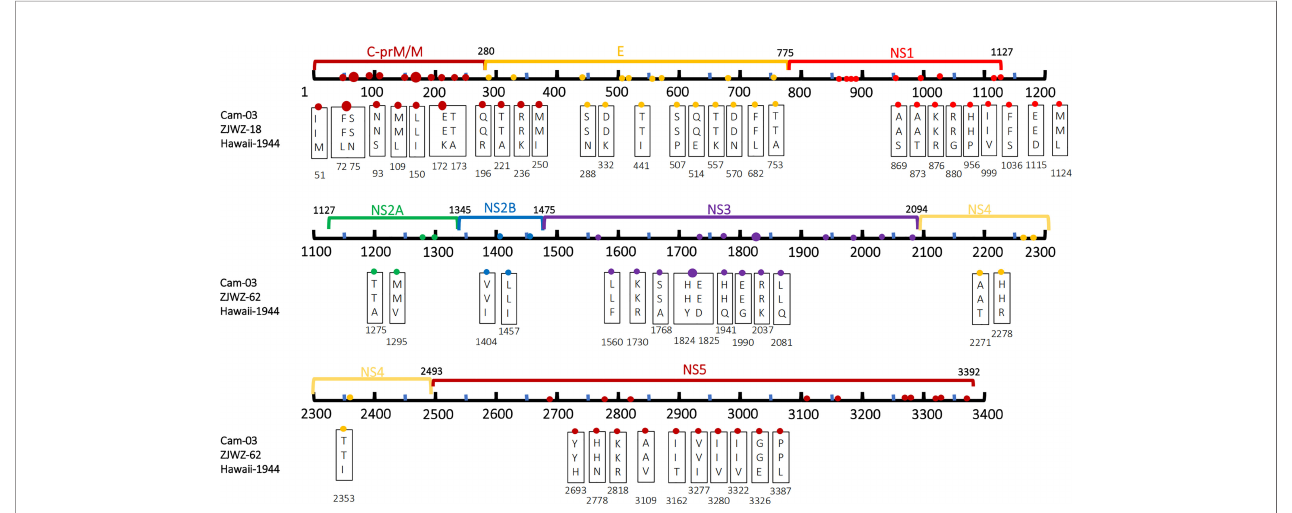
FIGURE 5 | Amino acid mutations both in Wenzhou local strain and traveling Cambodia strain compared with standard strain. The labeled numbers represent the amino acid